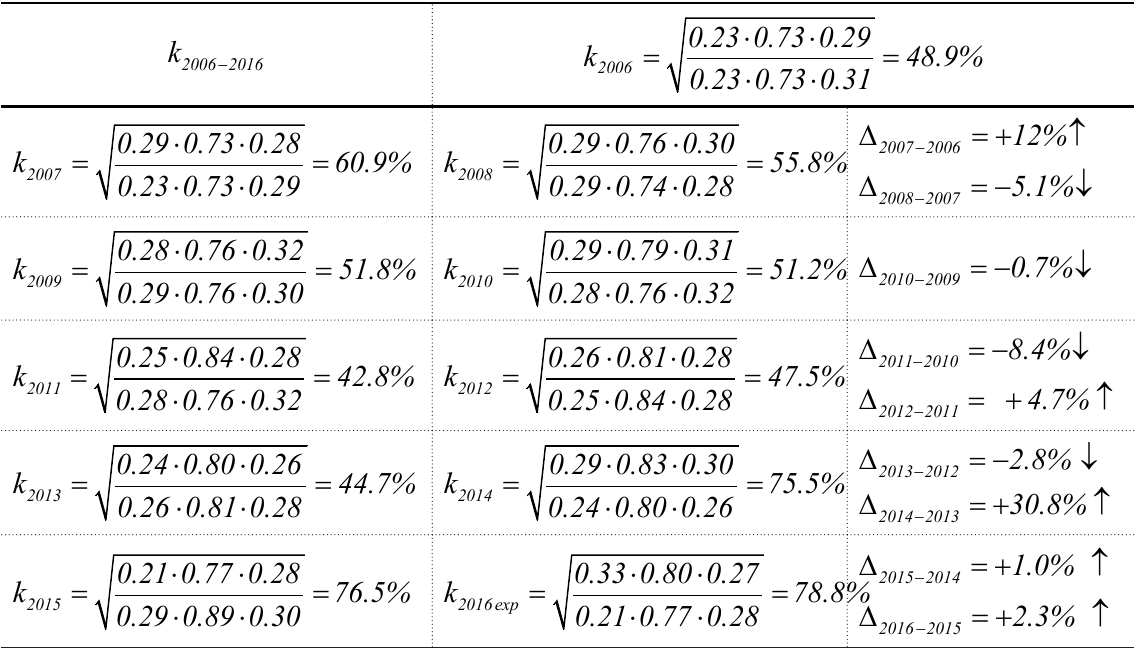
Table 7. Calculations of coefficient of the Ukrainian economy shadowing level in